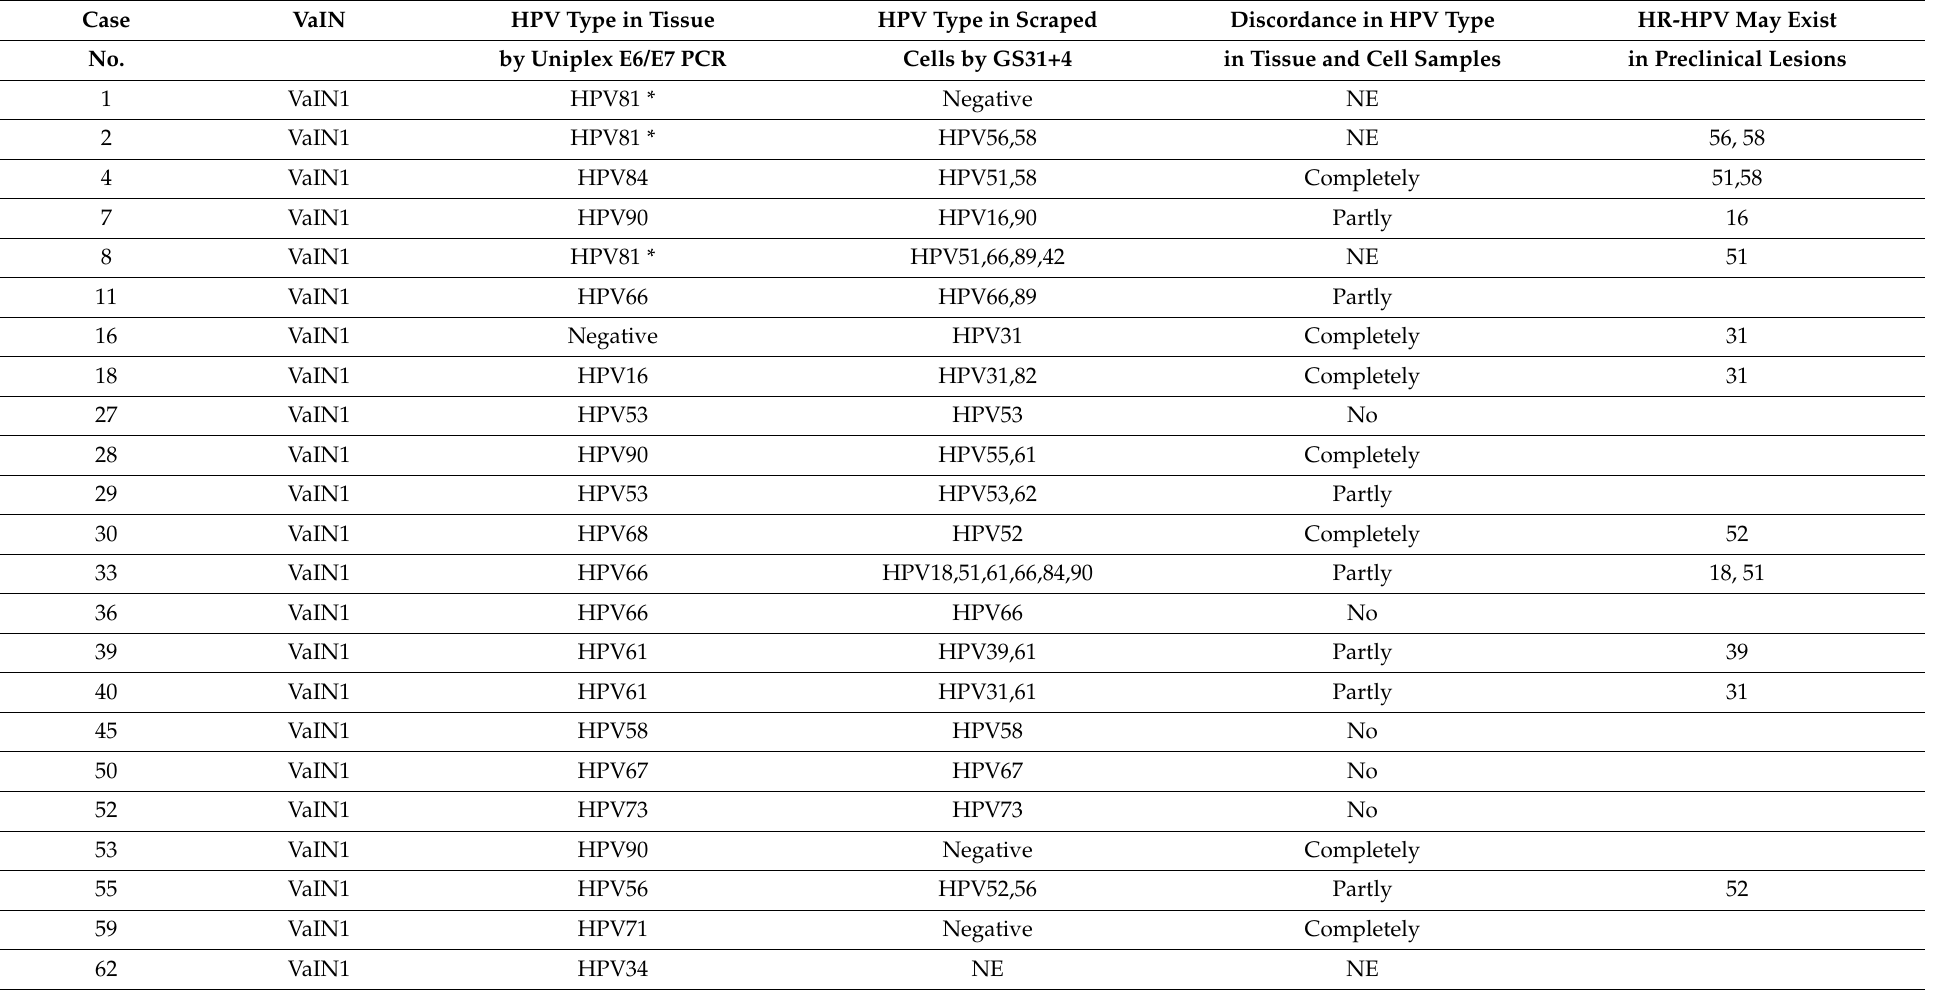
Table 3. Comparison of HPV type results determined by tissue or scraped cell samples in cases with a single